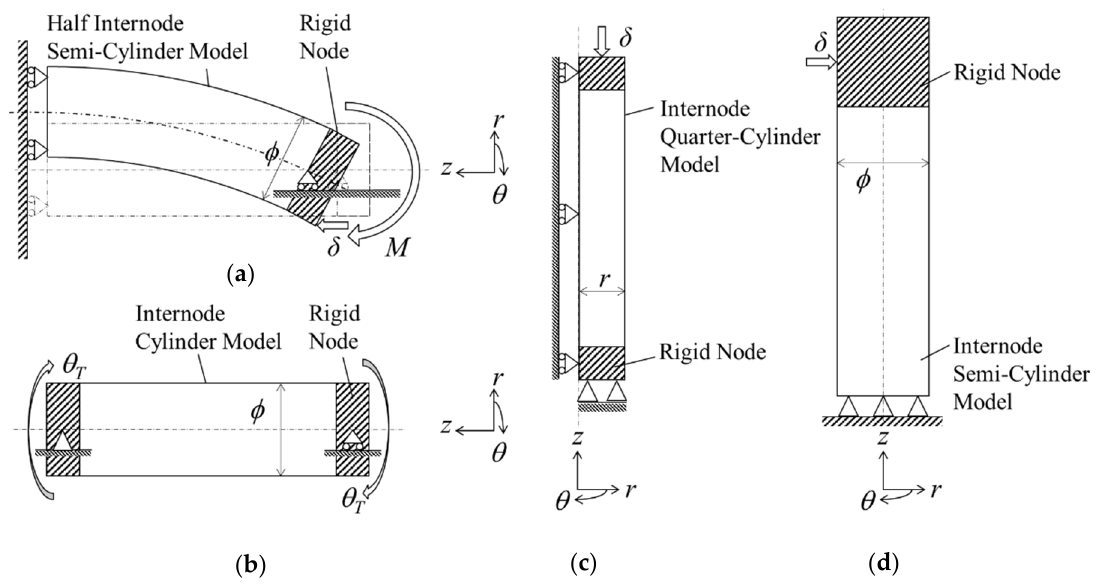
Figure 9. Schematic of boundary conditions of external loading conditions: ( a ) bending mode; ( b ) torsion mode; ( c ) compression mode and ( d ) shear mode.